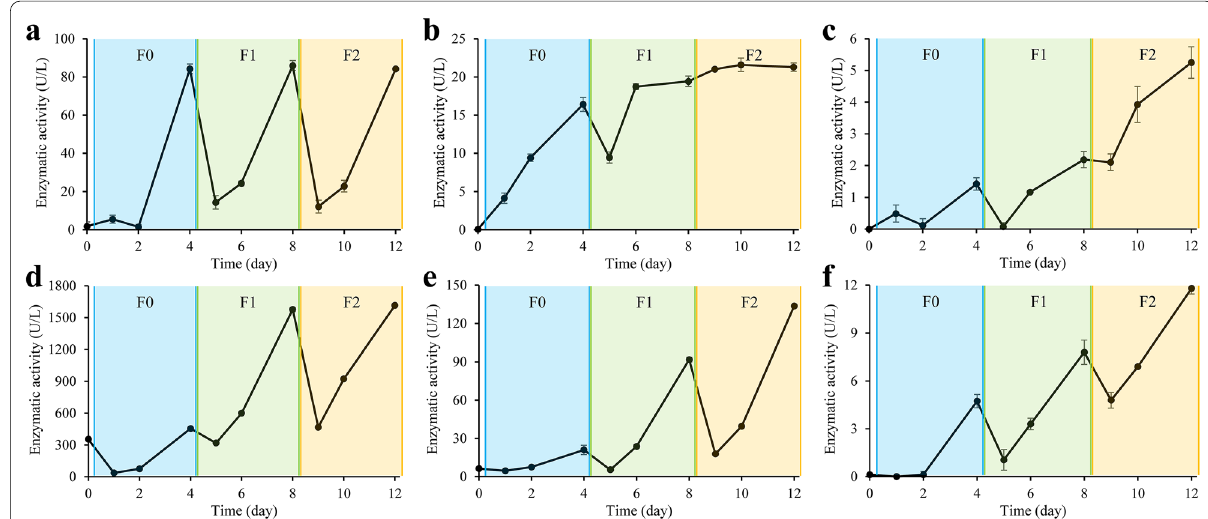
Fig. 4 Dynamic changes in cellulase and hemicellulase activities during revival. A Endo-β-1,4-glucanase activity, B β-glucosidase activity, C cellobiohydrolase activity, D endo-β-1,4-xylanase activity, E α-L-arabinofuranosidase activity, F β-xylosidase